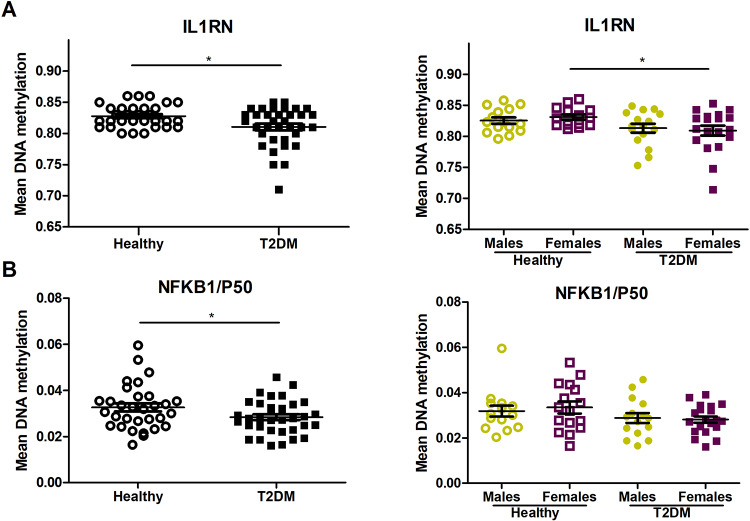
Average DNA methylation levels of target genes in PBMCs from type 2 diabetes mellitus (T2DM, n = 35) patients and healthy controls (Healthy, n = 31).(A) Mean methylation levels in IL1RN gene promoter (across 16 CpG loci) in all subjects and males/females; (B) Mean methylation levels in NFKB1 gene promoter (across 65 CpG loci) in all subjects and males/females. Results are expressed as mean ± SEM. *P< 0.05.